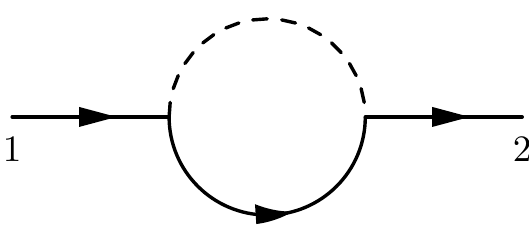
Figure 3 . One loop corrections to the fermion Keldysh propagator. Solid lines correspond to the tree-level fermion propagators, dashed lines correspond to the tree-level boson